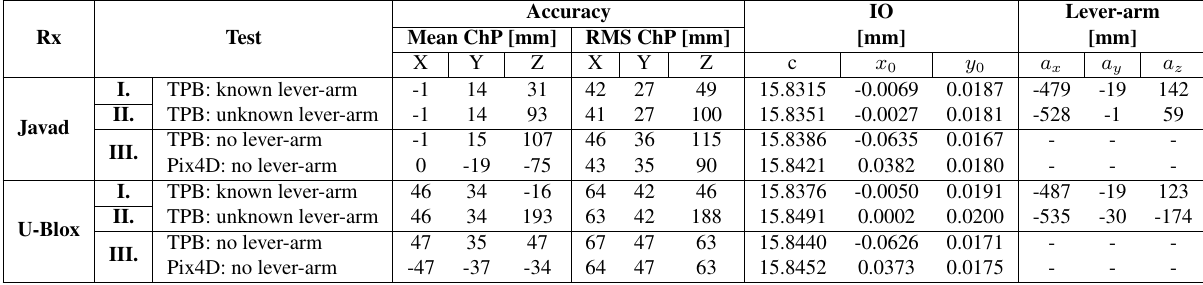
Table 3. Mapping accuracy at 23 ChP, with an absolute aerial position control, without GCPs, and with absolute aerial positions. The acronym TPB states for the TopoBun. The average GSD of these ISO projects is 4